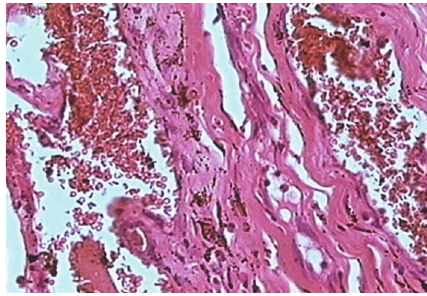
Figure 4: Histopathological section showing cavernous heman-